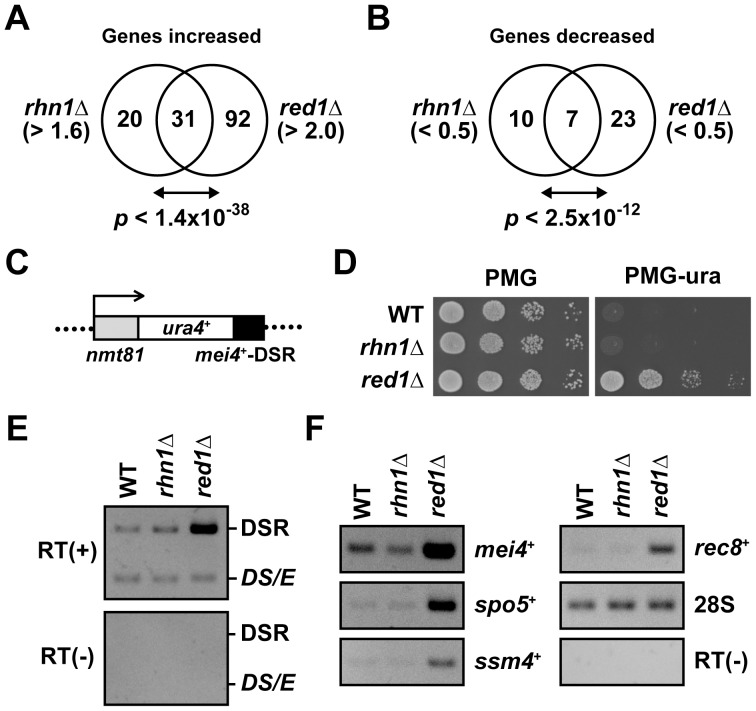
Rhn1 is dispensable for DSR-mediated mRNA elimination.(A and B) Venn diagrams of Rhn1-regulated genes and Red1-regulated genes. The genes upregulated in rhn1Δ (>1.6-fold) and red1Δ (>2-fold) strains (A) and downregulated (<0.5-fold) in rhn1Δ and red1Δ strains (B). We examined the expression of 4977 genes for these comparisons. We caluculated p-values to assess the statistical significance of the overlap between these groups; these p-values are shown under the respective diagrams. (C) Schematic representation of the ura4
+-DSR construct. The DSR region derived from mei4
+ was fused to the ura4
+ gene, and transcription of the ura4
+-DSR mRNA was driven by the thiamine-repressive nmt81 promoter. This construct was integrated into the lys1
+ locus. (D) The effect of ura4
+-DSR mRNA elimination in rhn1Δ cells. Serial dilutions of wild-type (WT), rhn1Δ, and red1Δ cells carrying the ura4
+-DSR were spotted onto minimal media plates without thiamine (PMG) and onto minimal media plates lacking uracil and thiamine (PMG-ura); the plates were then incubated at 30°C for 2 to 3 days. (E) No marked accumulation of ura4
+-DSR transcripts was evident in rhn1Δ cells. Total RNA samples were prepared from wild-type (WT), rhn1Δ, or red1Δ cells that carries both ura4
+-DSR (DSR) and the ura4
+ minigene (ura4DS/E (DS/E)) grown in PMG media without thiamine. The levels of ura4
+-DSR and ura4DS/E mRNAs were determined by RT-PCR. The ura4DS/E transcript was used as an internal control. RT (-), no reverse transcription. (F) The steady-state levels of mei4
+, spo5
+, ssm4
+, and rec8
+ mRNAs were not higher in mitotic rhn1Δ cells than in wild-type cells. The total RNA samples used in (E) were also subjected to RT-PCR analyses. The 28S rRNA (28S) was used as a control. RT (-), no reverse transcription.